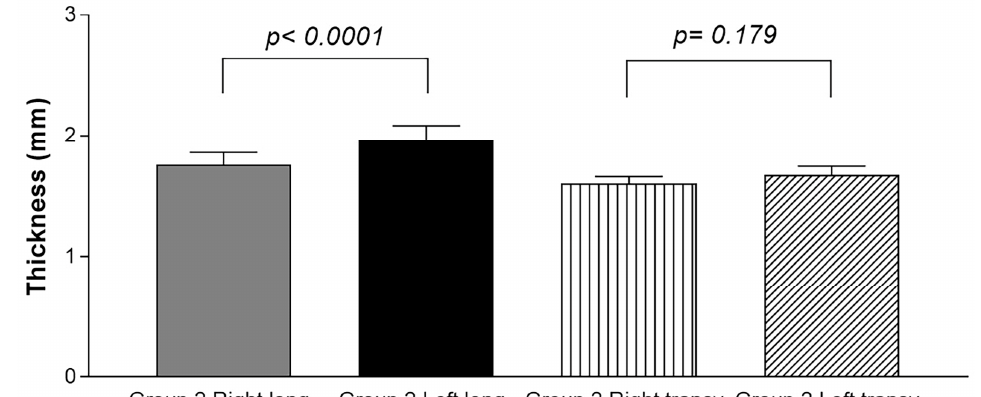
Figure 3. Ultrasound thickness measurements of the TLF in the healthy volunteers (Group 2). Long.: longitudinal axis; transv.: transverse axis.